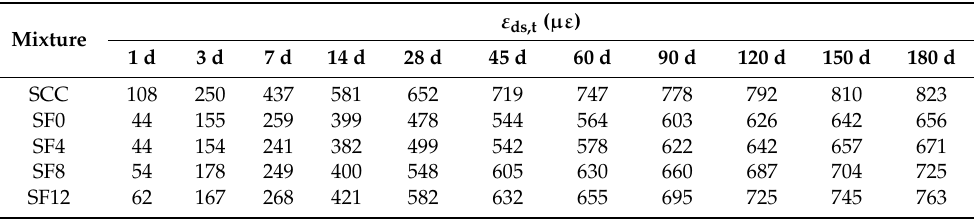
Table 7. Drying shrinkage of SCC and self-compacting